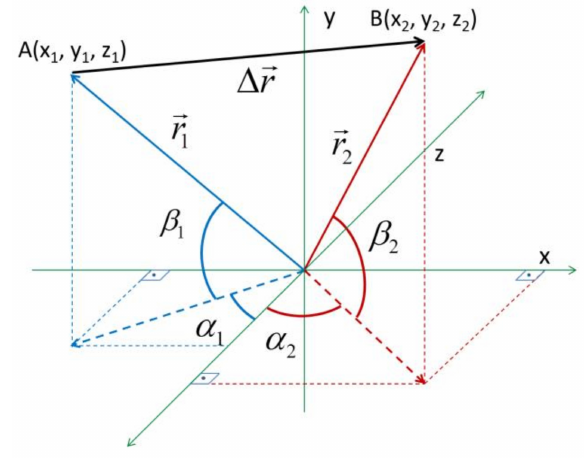
Figure 17. Calculation of the reflection angles